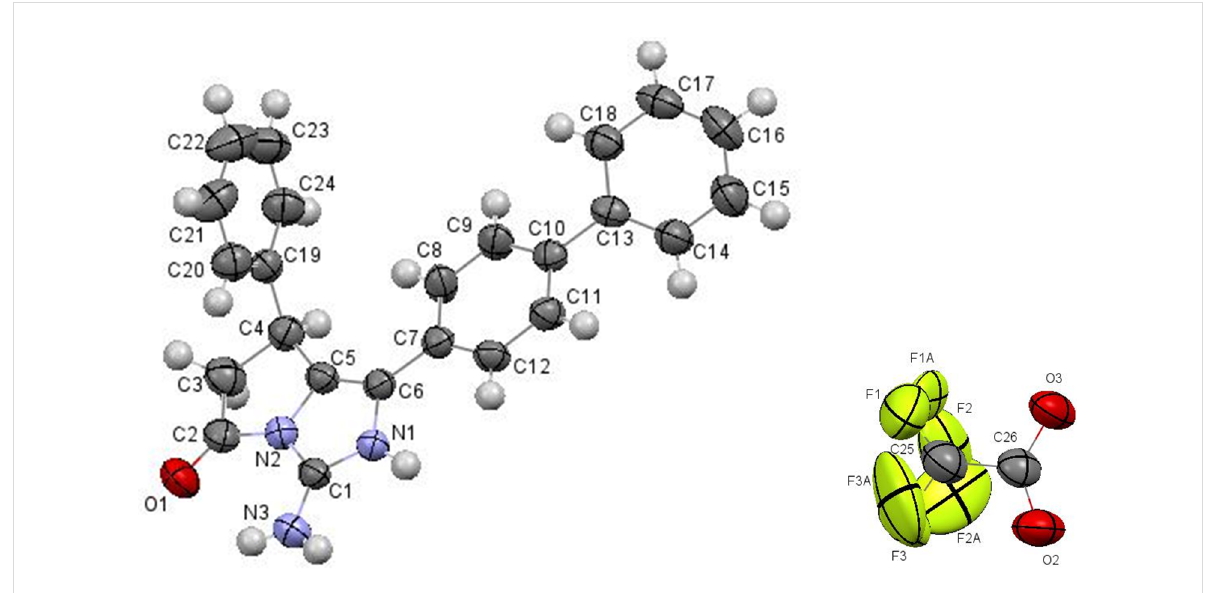
Figure 3: Molecular structure of 1-([1,1'-biphenyl]-4-yl)-5-oxo-7-phenyl-6,7-dihydro-5 H -pyrrolo[1,2- c ]imidazol-3-aminium 2,2,2-trifluoroacetate 9i ac- cording to X-ray diffraction data. Thermal ellipsoids of atoms are shown at 50% probability level.